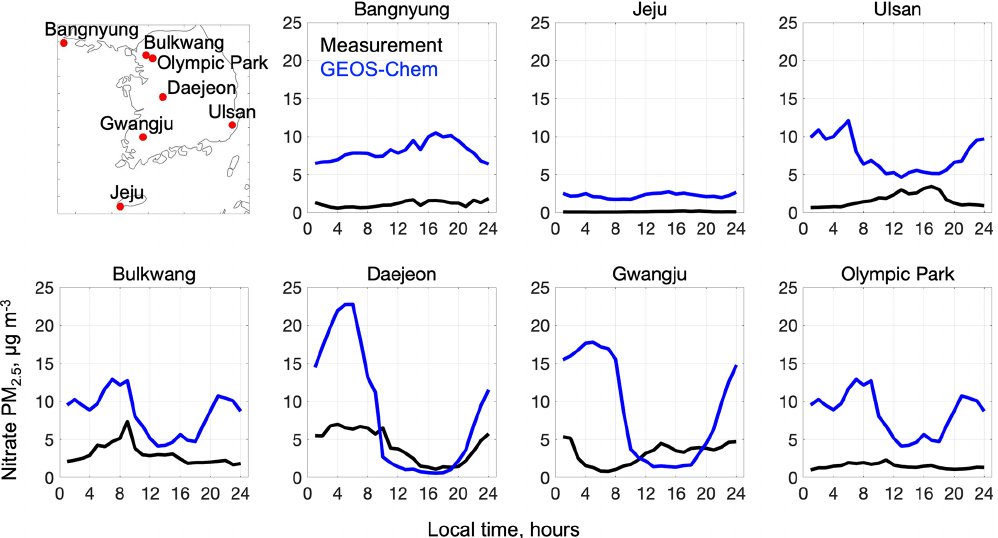
Figure 5. Median diurnal variations in PM 2 . 5 nitrate concentrations at the seven supersites (top left panel) operated in South Korea during KORUS-AQ (9 May–10 June 2016). Values are medians binned by hour. GEOS-Chem model values are sampled to coincide with the